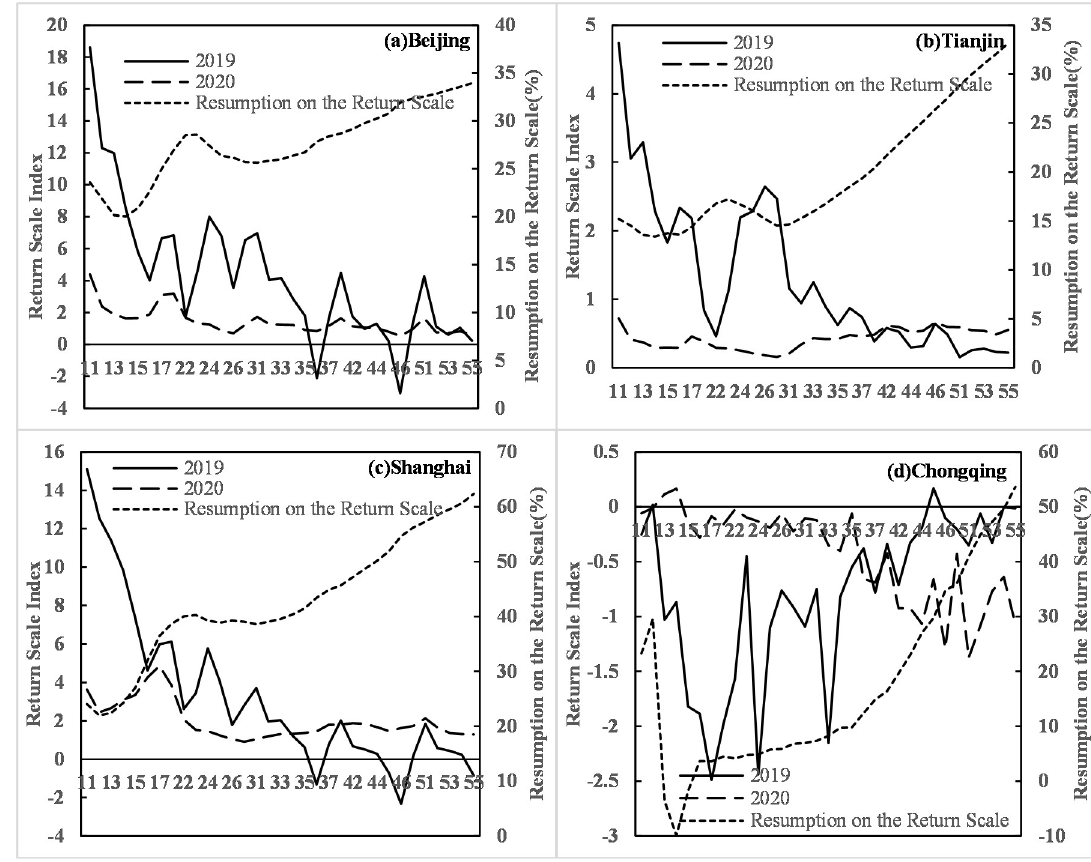
Fig 2. Daily changes in the return scale index and resumption of return scale in Beijing, Tianjin, Shanghai and Chongqing.